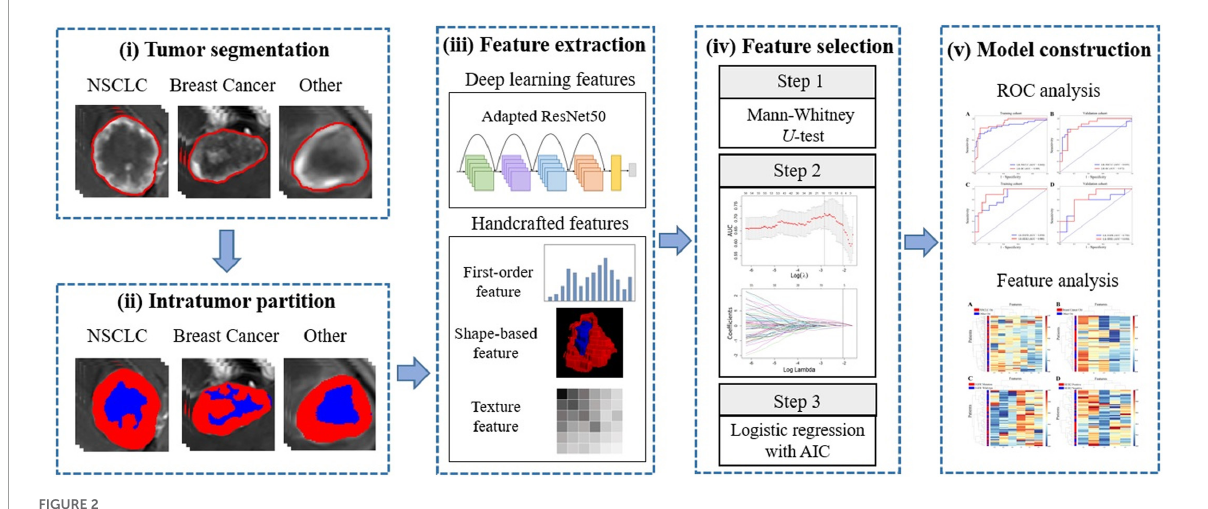
FIGURE2 The flowchart of radiomics analyses.